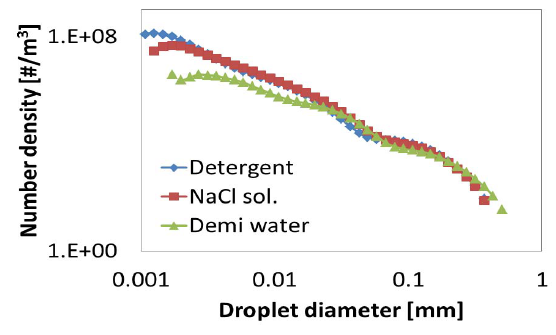
Fig. 9. A number density distribution of the droplets.